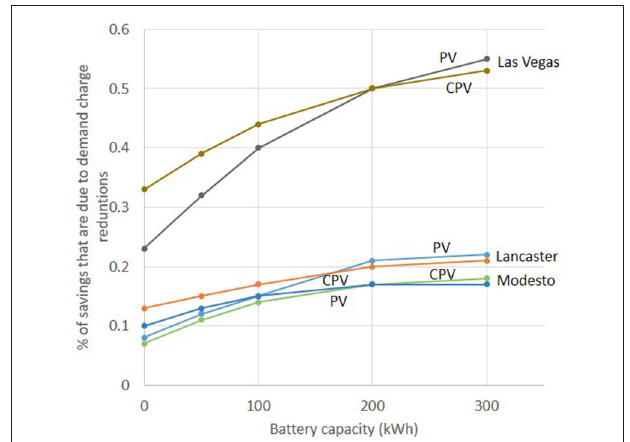
FIGURE 6 | Percentage of the dollar savings that is due to reduced demand charges as a function of battery size for Lancaster, CA, with the 8a.m. demand